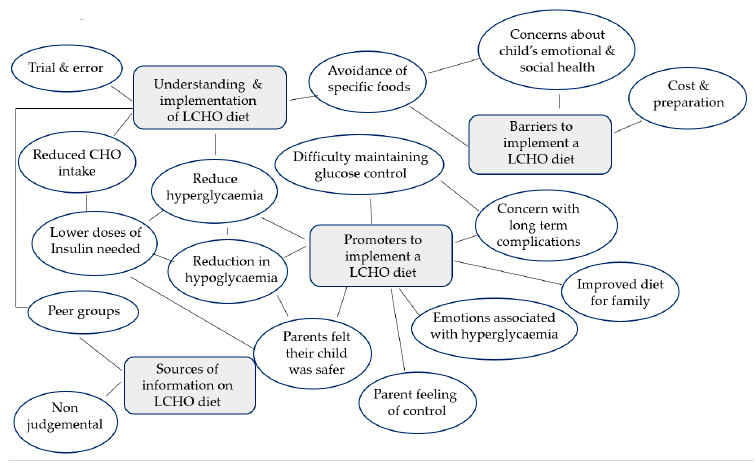
Figure 1. Thematic map of key fi ndings.